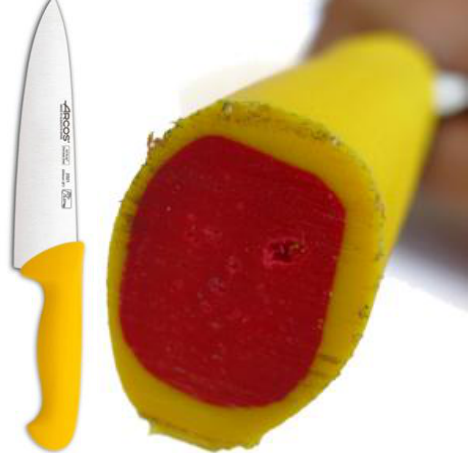
Figure 7. Recycled PP content of the ecodesigned knife produced by Arcos within ENISA Ecodesign Pilot Project (ENISA, 2012)